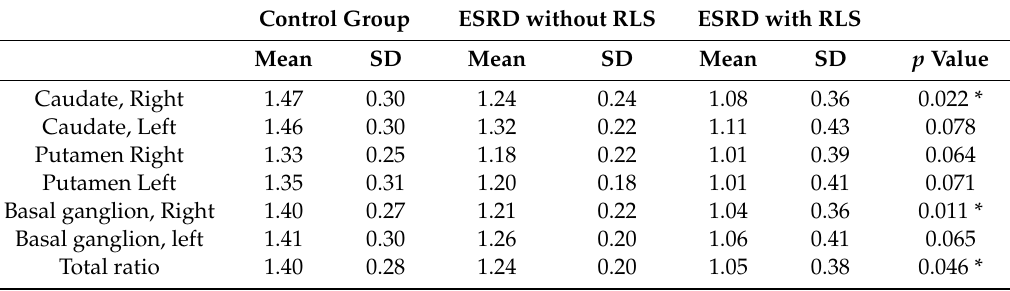
Figure 2. Comparative TRODAT ratio between the control and ESRD with RLS groups.